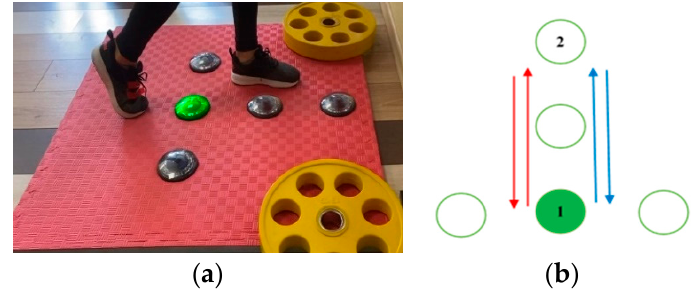
Figure 2. Test 1 (motion in the anterior–posterior direction): ( a ) starting position for right leg execution; ( b ) movement pattern.